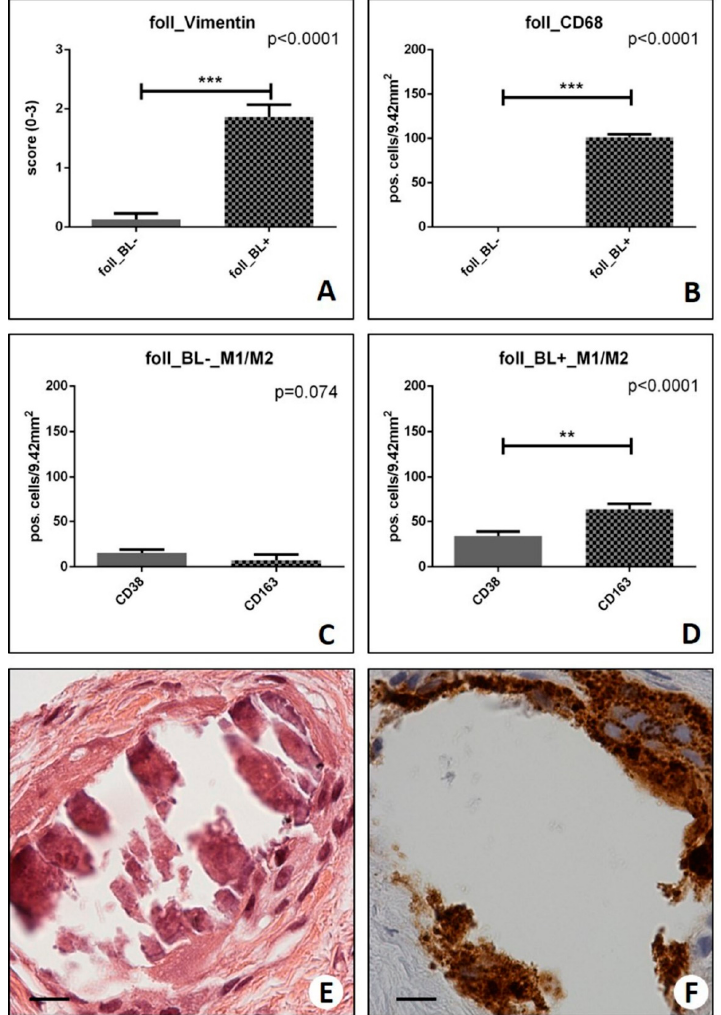
Figure 7. Evaluation of macrophages polarization in breast biopsies. ( A ) Graph shows the expression of vimentin in benign lesions without microcalcification (foll_BL − ) and benign lesions with microcalcification (foll_BL+), groups. ( B ) Graph shows the expression of CD68 in foll_BL − and foll_BL+, groups. ( C ) Graph displays the expression of CD68 and CD163 in foll_BL − . ( D ) Graph displays the expression of CD68 and CD163 in foll_BL+. ( E ) H&E staining shows a CO calcification in fibroadenoma. ( F ) Several CD163-positive cells surrounding the breast microcalcification. (* p < 0.05; ** p < 0.01; *** p < 0.001). Scale bar represents 100 µm in all images.